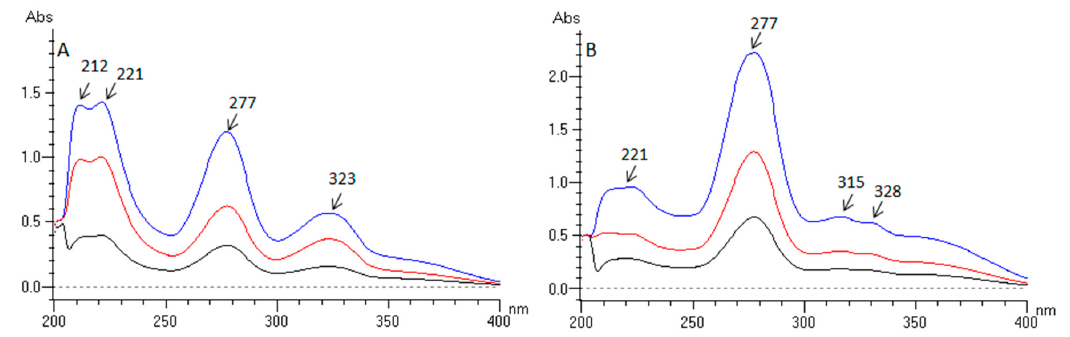
Figure 2. UV absorption spectra of ciprofloxacin ( A ) and ciprofloxacin-Bi complex ( B ) as a function of the concentration in µ g / mL: 5 (back line), 10 (red line), 20 (blue line). The increase in absorbance was proportional to the increase in molar concentration for both Cip and Cip-Bi (at λ = 277 nm: y = 34.69x + 0.02, R = 0.9999 for Cip-Bi and y = 29.85x + 0.20, R = 0.9975 for Cip; ratio of the slopes of regression lines, Cip-Bi/Cip: 1.16). Molar absorptivity was determined to